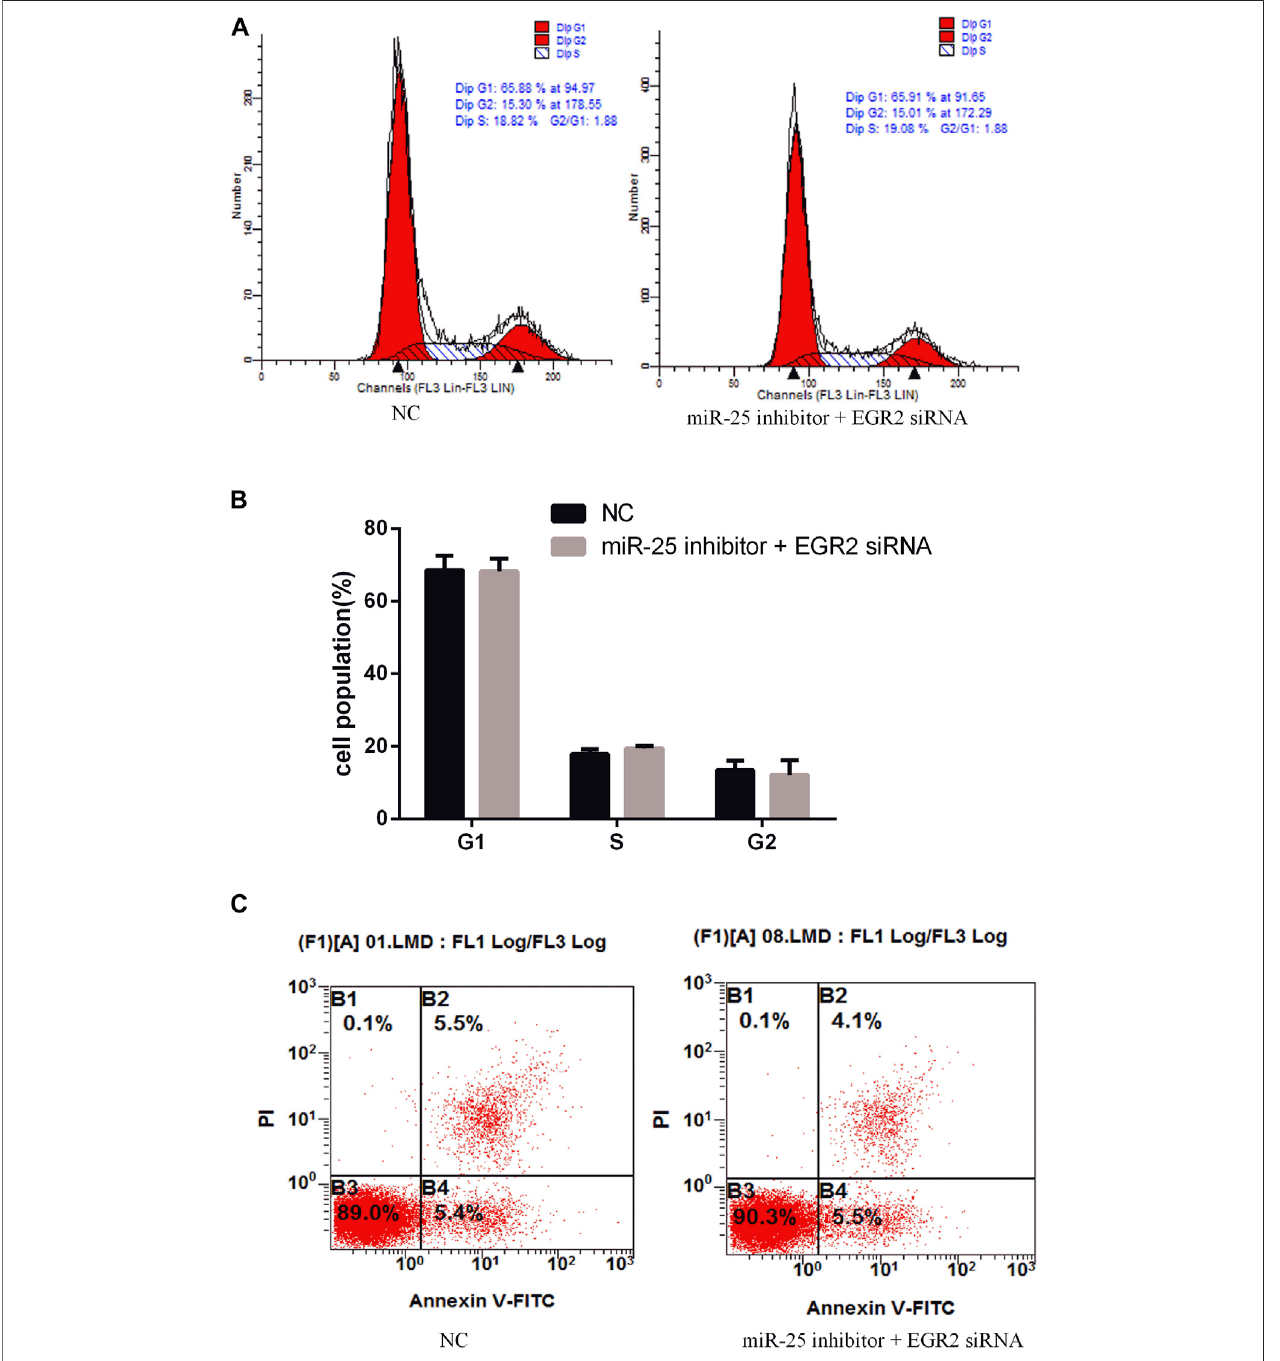
FIGURE 7 | Knockdown of EGR2 counteracts the role of miR-25 inhibitor. (A) Cell cycle were analyzed by fl ow cytometry after being co-transfected with miR-25 inhibitor and EGR2 siRNA. (B) Cell number statistics at each stage of cell cycle. (C) After being co-transfected miR-25 inhibitor and EGR2 siRNA, cell apoptosis was detected by Annexin V-FITC